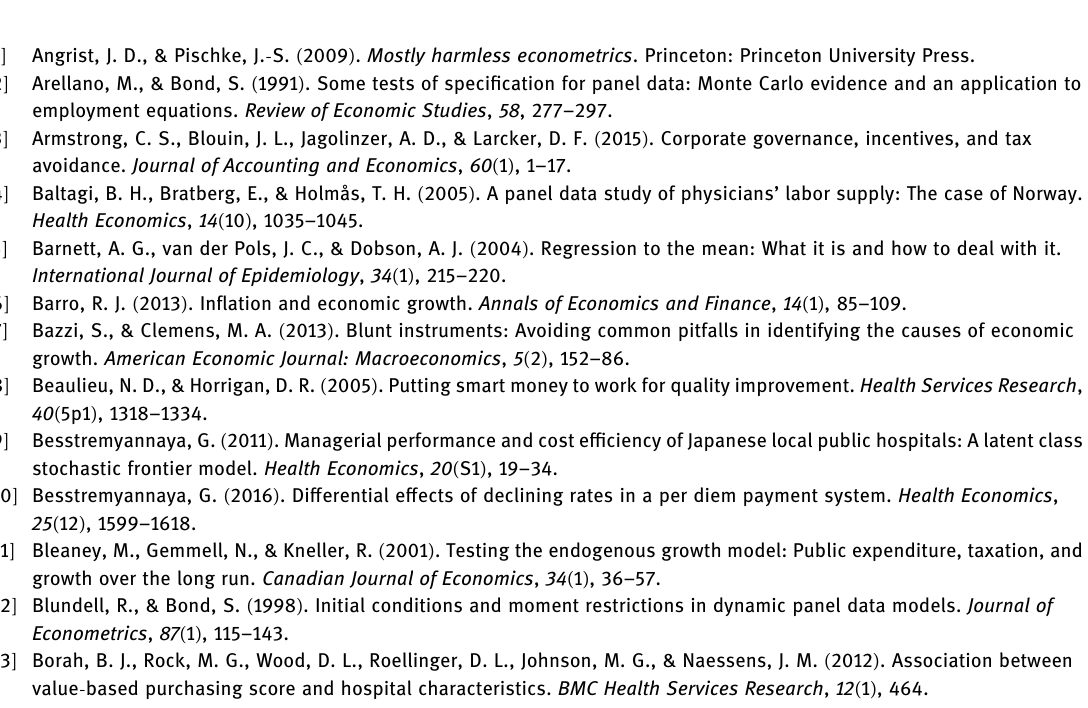
Table A7: Download links for the EHR Incentive Program data Stage Link 1 https://www.cms.gov/Regulations - and - Guidance/Legislation/EHRIncentivePrograms/Downloads/EH_PUF_ Q32018Stage1.zip 2